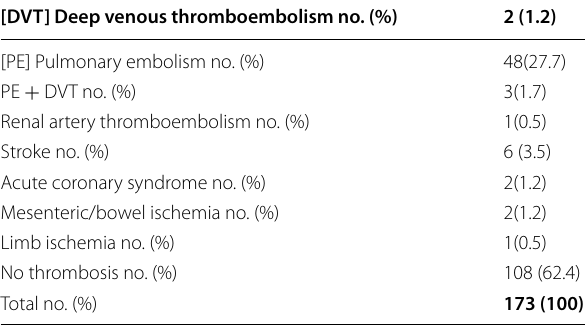
Table 1 Frequency and sort of the thromboembolic events associated with our COVID‑19